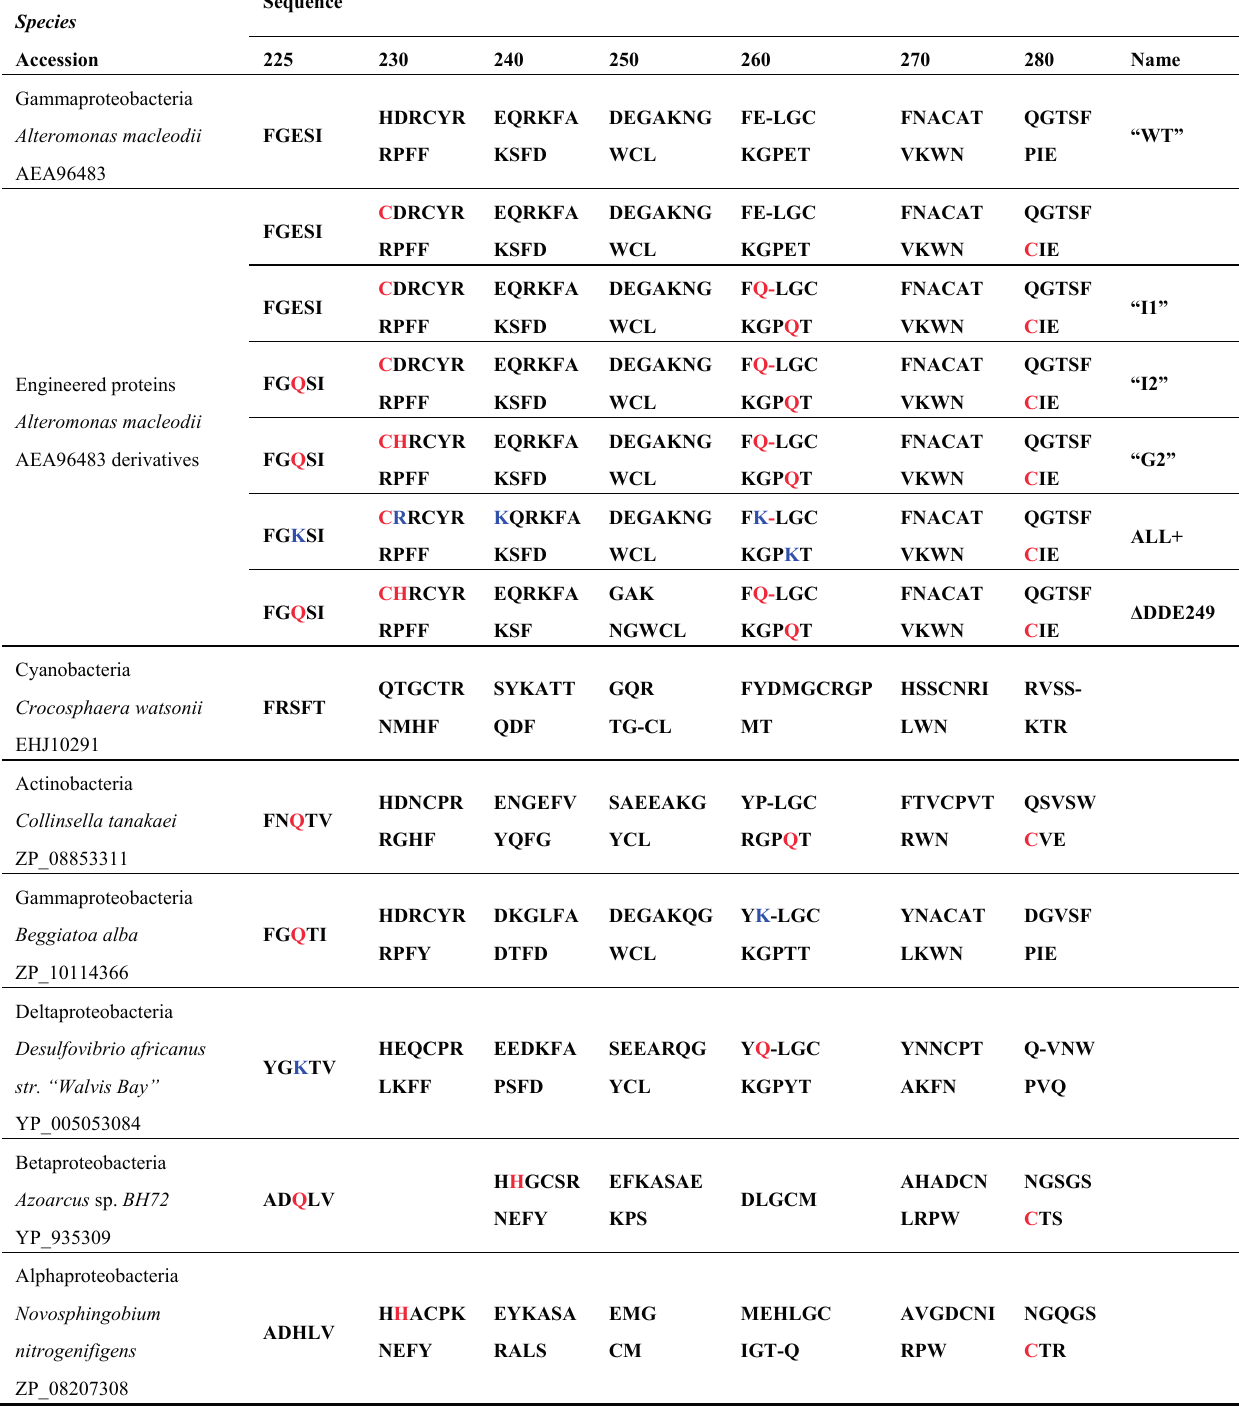
Table 1. An alignment of the “surface patch” region of the A. macleodii hydrogenase and designed hydrogenases with select members of the hydrogenase small subunit family. The “ALL+” construct features five further substitutions outside of the alignment window. Substituted residues for each sequence are indicated red or blue with blue indicating substitution to positively charged